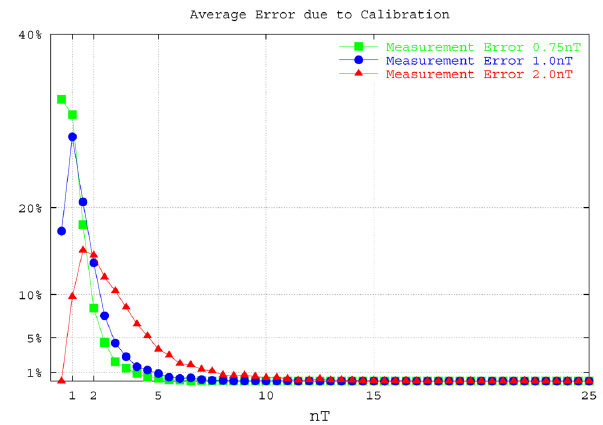
Fig. 5. Normalized histograms of the calibration errors for CLF ob- servatory during 1999: the average possible error for εb =0.75, 1, 2nT.